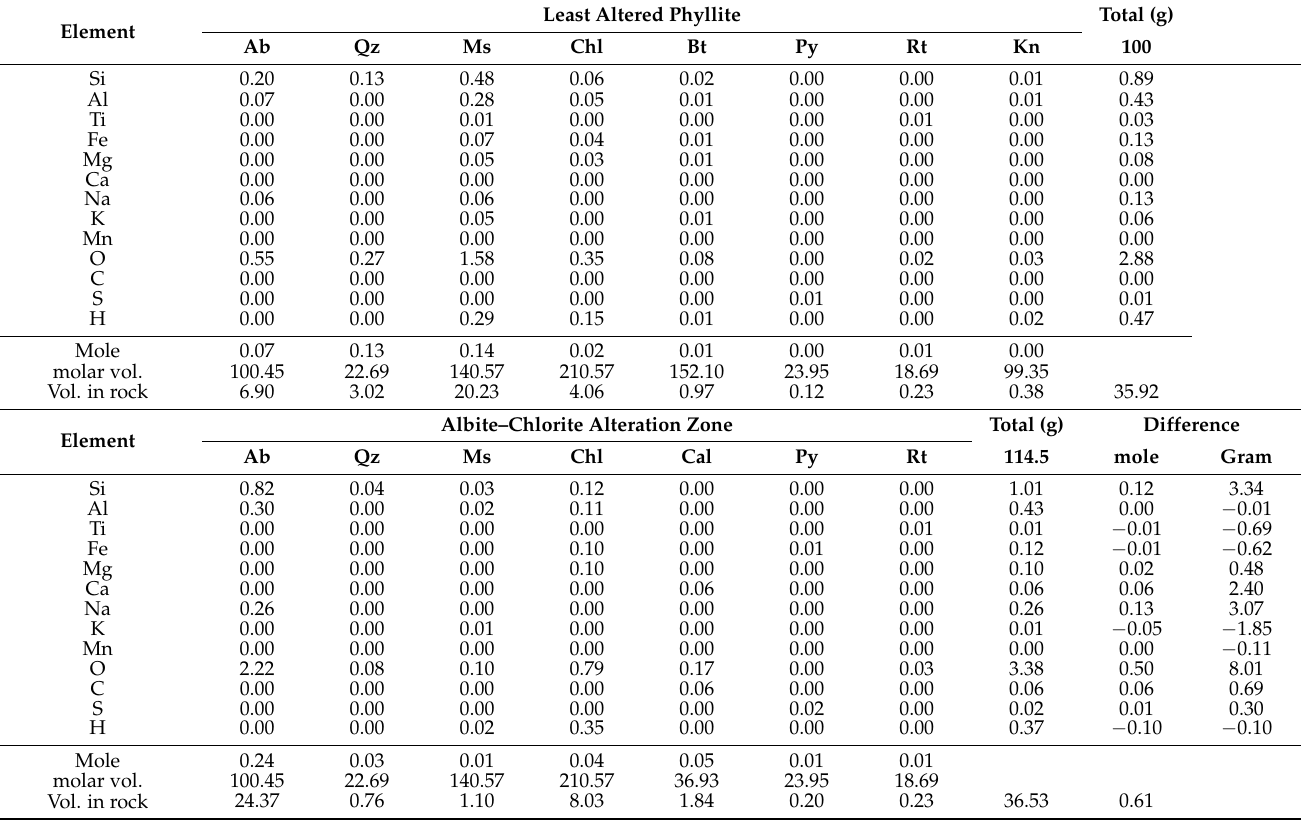
Table 6. Quantified compositional data for the least altered phyllite and the albite–chlorite alteration zone. The calculation was based on modal and mineral compositions balanced for immobile Al and a 14.5% mass increase. The difference indicates gain or loss/100 g for components and in % for volume changes in rock.